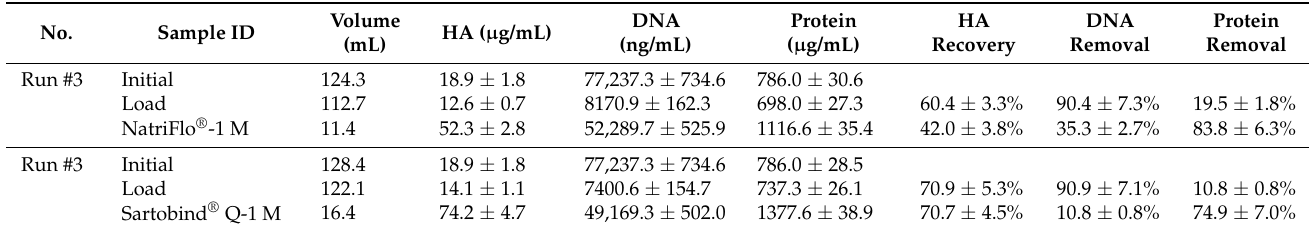
Table 3. Chromatography results of NatriFlo ® HD Q vs. Sartobind ® Q.